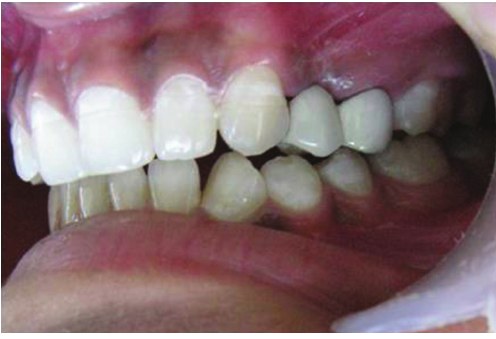
Figure 33: Left lateral view of teeth in functional harmony 2 years